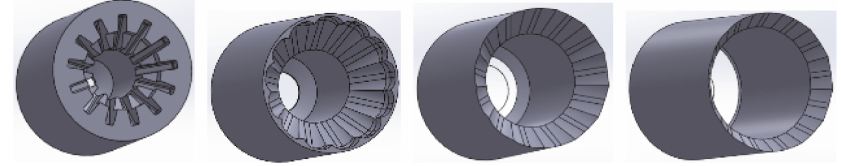
Figure 12: Optimum grain variant burnback from left to right at 0mm, 120mm, 220 mm, and 320mm